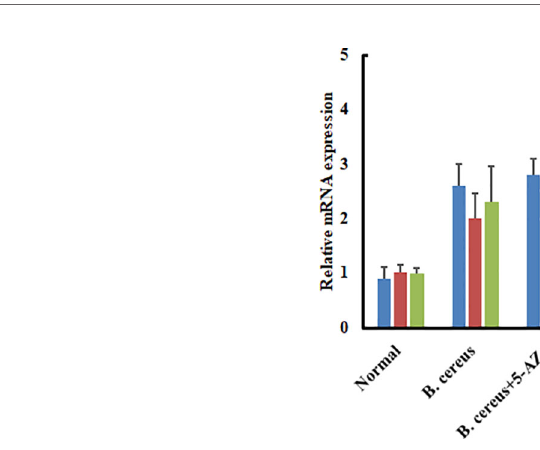
FIGURE 11 | Treatment with 5-AZA modulated the expression of Toll and IMP pathway-associated genes in A. pernyi following bacterial infections. RT-qPCR analysis of relish, Toll-like receptor, and dorsal con fi rmed that 5-AZA administration altered the expression levels of these pathways-associated genes in response to B cereus and E. coli . 18S was used as the reference gene in RT-qPCR. Reactions from three biological replicates were repeated three times. Bars show mean ± S.E. (n = 3), and asterisks indicate signi fi cant differences (* p <